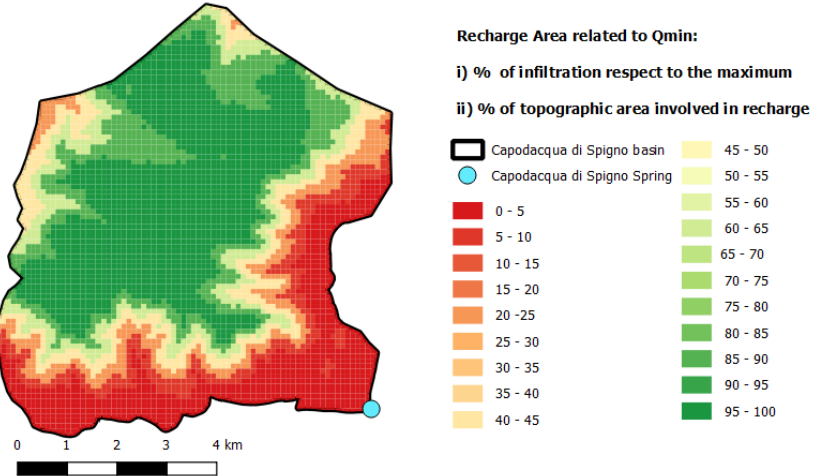
Figure 11. Recharge area distribution related to Qmin.